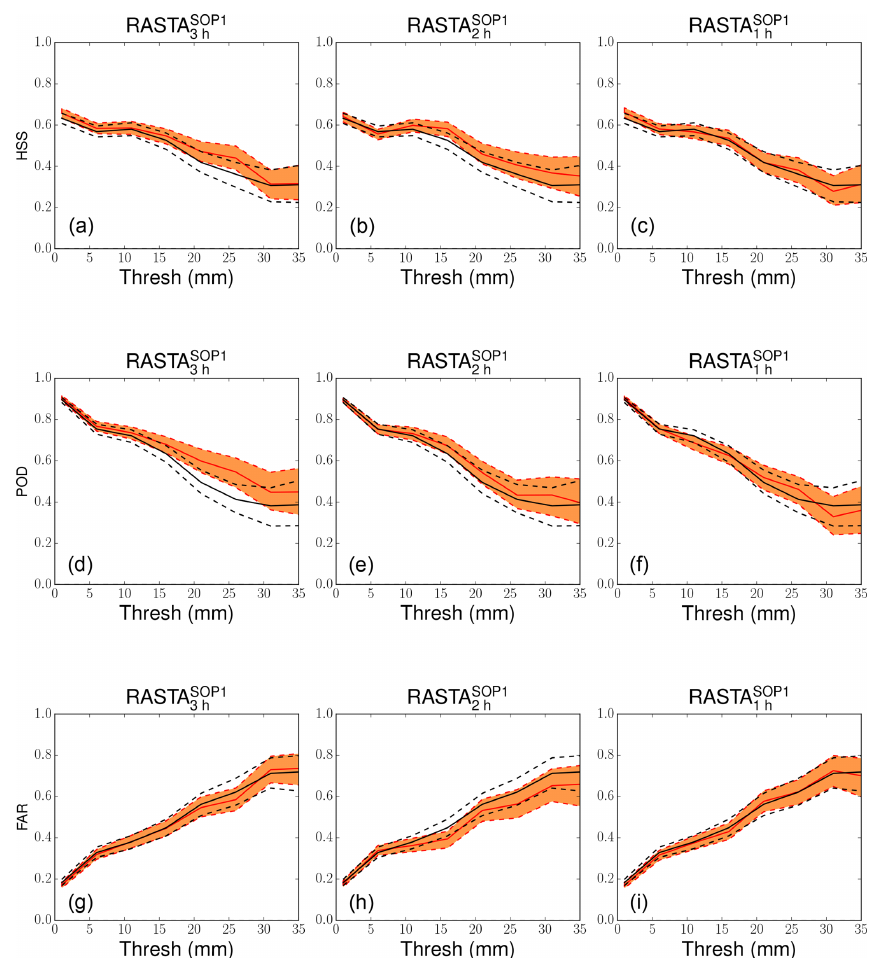
Figure 10. HSS (a, b, c) , POD (d, e, f) and FAR (g, h, i) of the 8h cumulated precipitation forecasts vs. rain gauge measurements for the three RASTA experiments (in red) and for the CTRL SOP1 experiment (in black). Calculations were performed over the 35 runs in which RASTA wind data were assimilated with the largest assimilation window. The error bars (dashed lines) represent the 90% bias-corrected and accelerated (BCa) bootstrap confidence intervals (see Efron and Tibshirani,